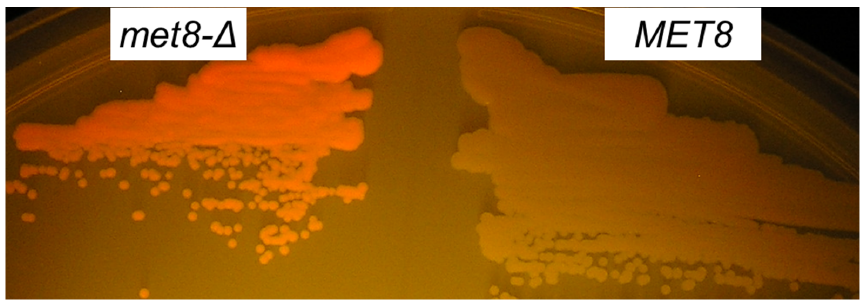
Figure 2. Fluorescence of O. parapolymorpha met8- Δ colonies irradiated by 402 nm LED light. The met8- Δ mutant ( met8- Δ ) and original strain with wild-type MET8 allele ( MET8 ) were streaked on YP-1% Glycerol medium and incubated for 2 days to obtain single colonies, which were irradiated by 402 nm LED and photographed through an orange filter.